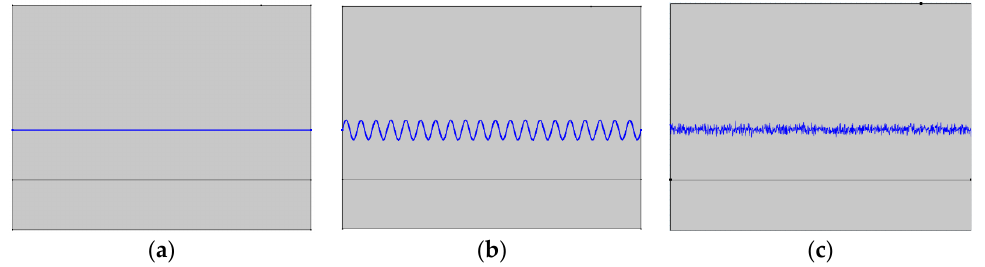
Figure 7. Schematic diagram of water level fluctuation form: ( a ) straight line, ( b ) sine wave and ( c ) random function.